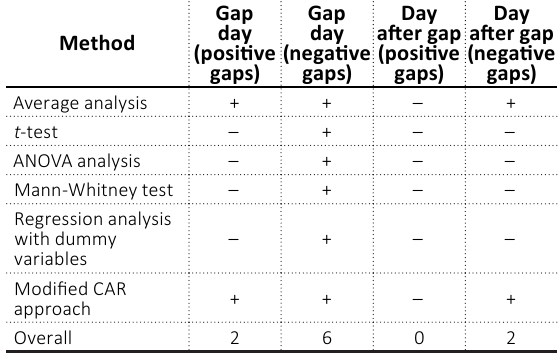
Table 5. Efficiency of the trading strategy based